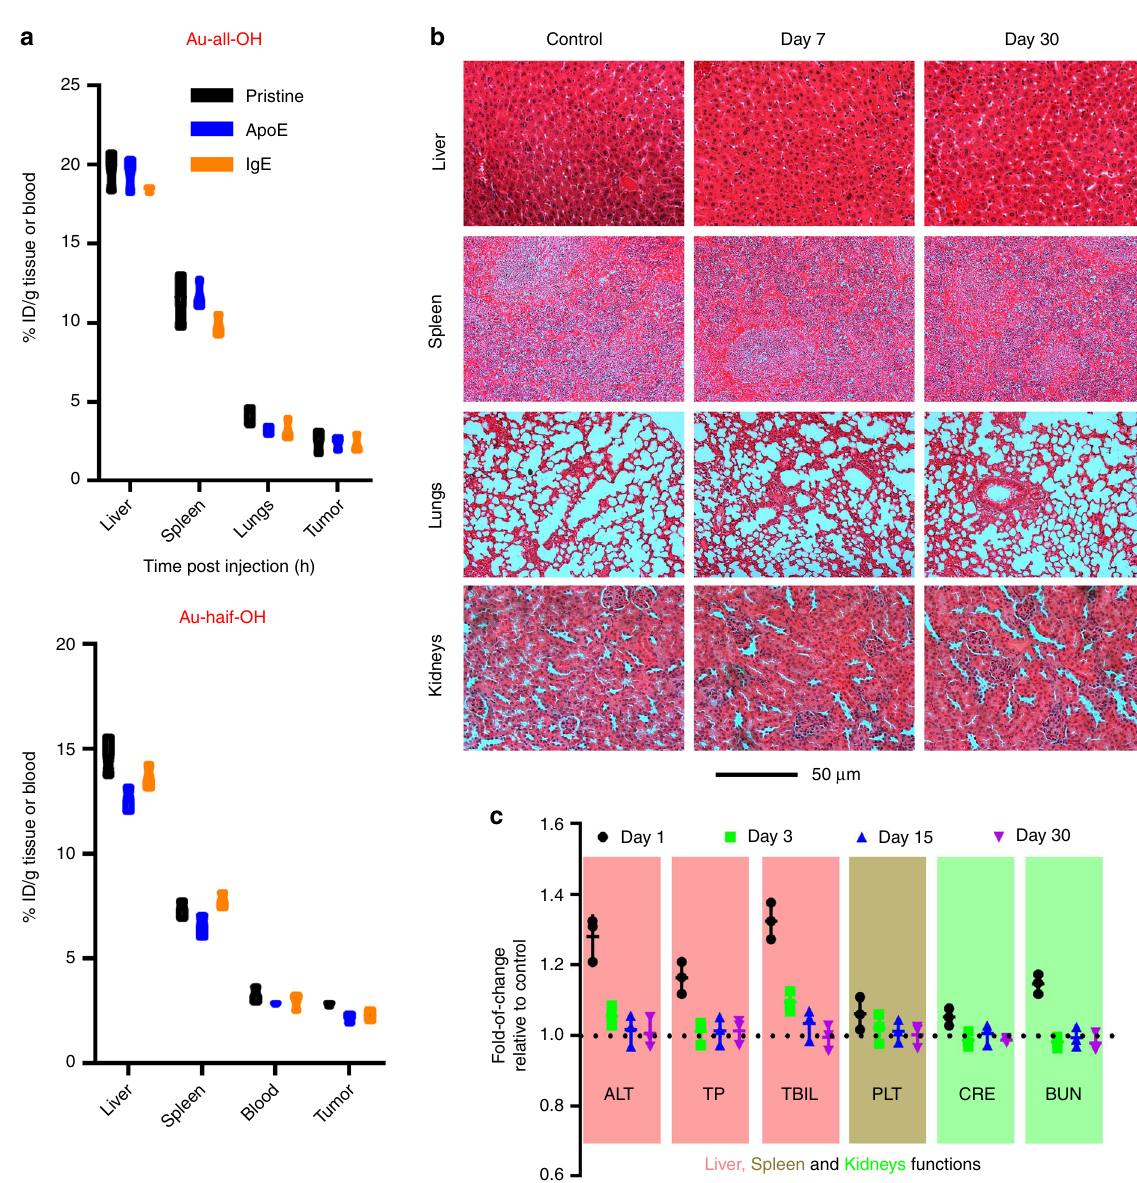
Fig. 10 Long-term toxicity. a Content of Au element remained in blood and three tissues, including liver, spleen, and tumor at Day 30 post injection. The mice carrying tumor received six types of materials including Au-half/all-OH in the pristine forms and their four derivatives coated with either ApoE or IgE. Data are presented as mean ± s.e.m. ( n = 3). p Values were calculated using multiple t tests with no inner-group difference of statistical signi fi cance can be found. b Pathological analysis of major organs after a 7 and 30 days of exposure to ApoE-coated Au-all-OH. The tissue sections were stained with H&E. c Changes in the levels of biomarkers that would indicate a compromised tissue function. ALT alanine aminotransferase, TP total proteins, TBIL total bilirubin, PLT platelet, CRE creatinine, BUN blood urea nitrogen. Data are presented as mean ± s.e.m. ( n =